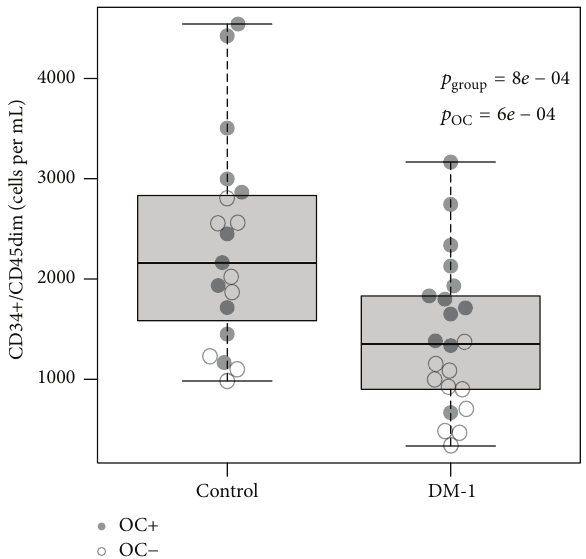
Figure 2: Boxplot of number of CD34+/CD45dim cells for both study groups. CD34+/CD45dim cells were significantly reduced in patients with DM-1 ( 𝑝 = 8 ⋅ 10 −4 ). OC use was associated with increased numbers of CD34+/CD45dim cells, regardless of study group ( 𝑝 = 6 ⋅ 10 −4